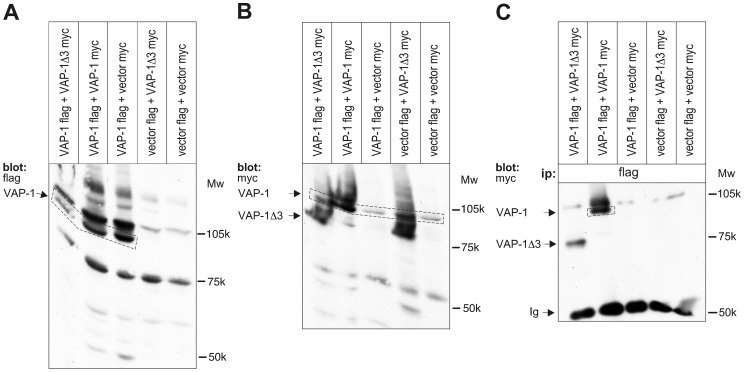
Heterodimerisation of VAP-1 and VAP-1 Δ3.Lysates of HEK293 cells co-transfected with flag-tagged VAP-1 cDNA, myc-tagged VAP-1Δ3 cDNA or with the corresponding tagged empty vectors in different combinations were separated in SDS-PAGE (with or without prior immunoprecipitation) and blotted to nitrocellulose membranes. The functionality of the tagged constructs and the ability to detect the proteins with corresponding antibodies was first verified by using the flag-antibody (A) or the myc-antibody (B) in control gels without prior immunoprecipitations. Aliquots of the same lysates were then immunoprecipitated with the flag antibody prior to gel electrophoresis, and the immunoprecipitated product was detected using the myc-antibody (C). The sizes of the two VAP-1 isoforms and the molecular weight markers are indicated. Ip Immunoprecipitation, Ig Immunoglobulin.